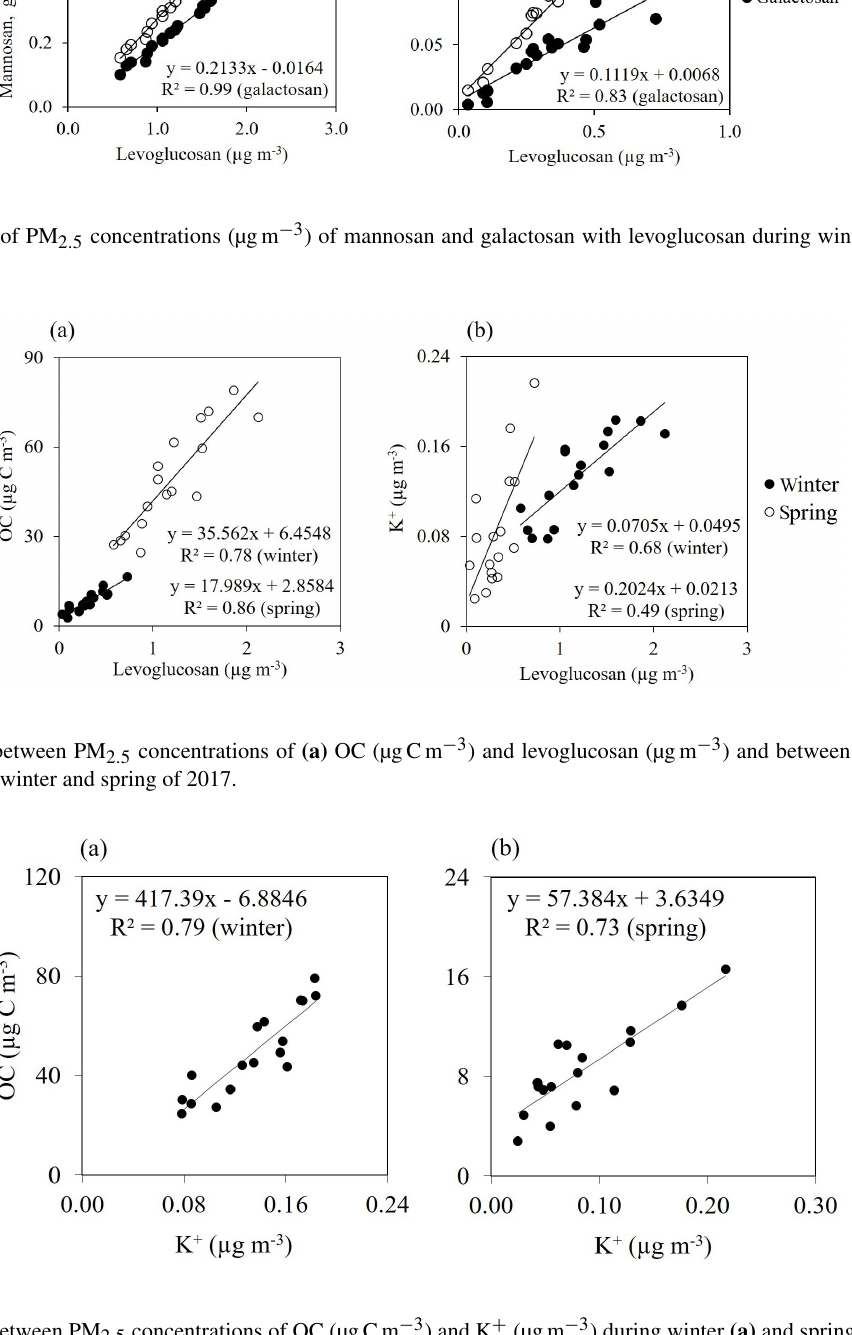
Figure 9. Correlation between PM 2 . 5 concentrations of OC (µgCm − 3 ) and K + (µgm − 3 ) during winter (a) and spring (b) of